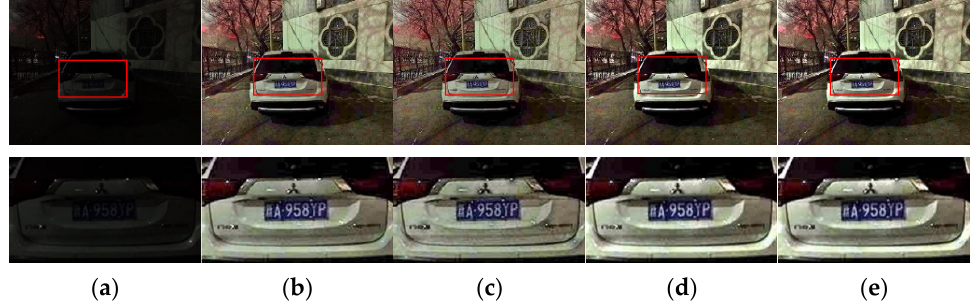
Figure 6. ( a ) Test image and its detail map, ( b ) guided filter refining transmission result and its detail map, ( c ) AnisGF refining transmission result and its detail map, ( d ) guided filter refining transmission + dark channel refining result and its detail map, and ( e ) AnisGF refining transmission + dark channel refining result and its detail map.